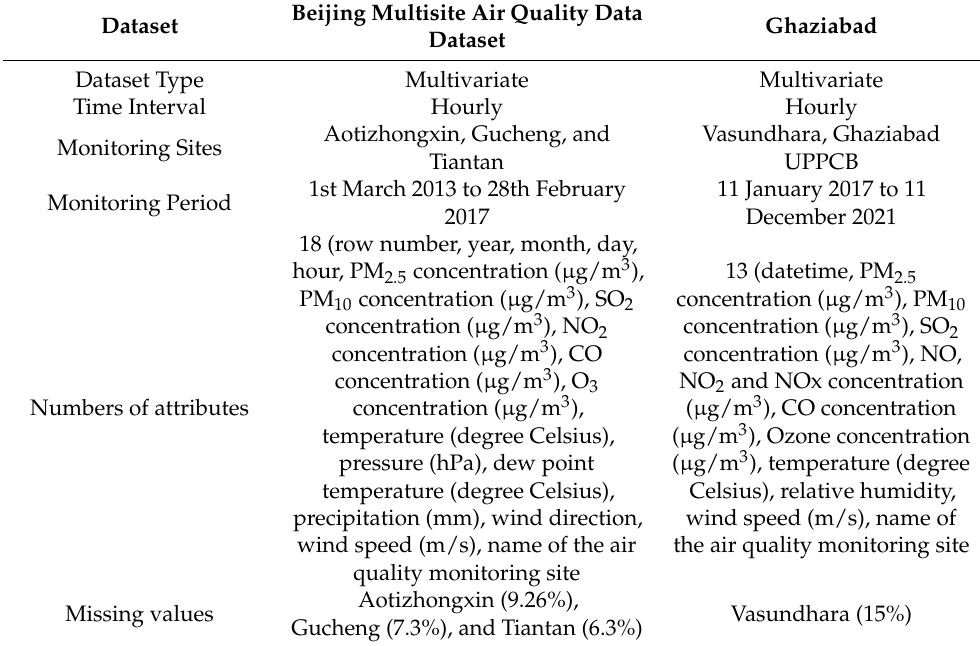
Table 2. Dataset